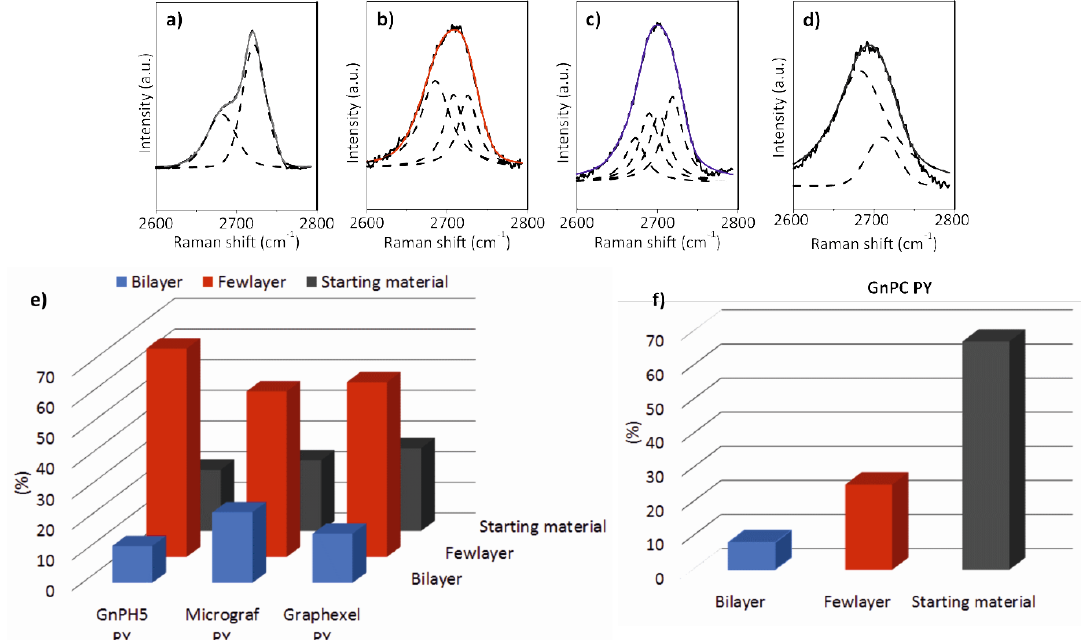
Figure 6. Lorentzian features of the deconvoluted 2D band of ( a ) graphite starting material (Graphexel), ( b ) few-layer graphene, ( c ) bilayer graphene, and ( d ) GnPC starting material; ( e ) yield of exfoliation process for Graphexel, Micrograf, GnPH5, and ( f ) GnPC.